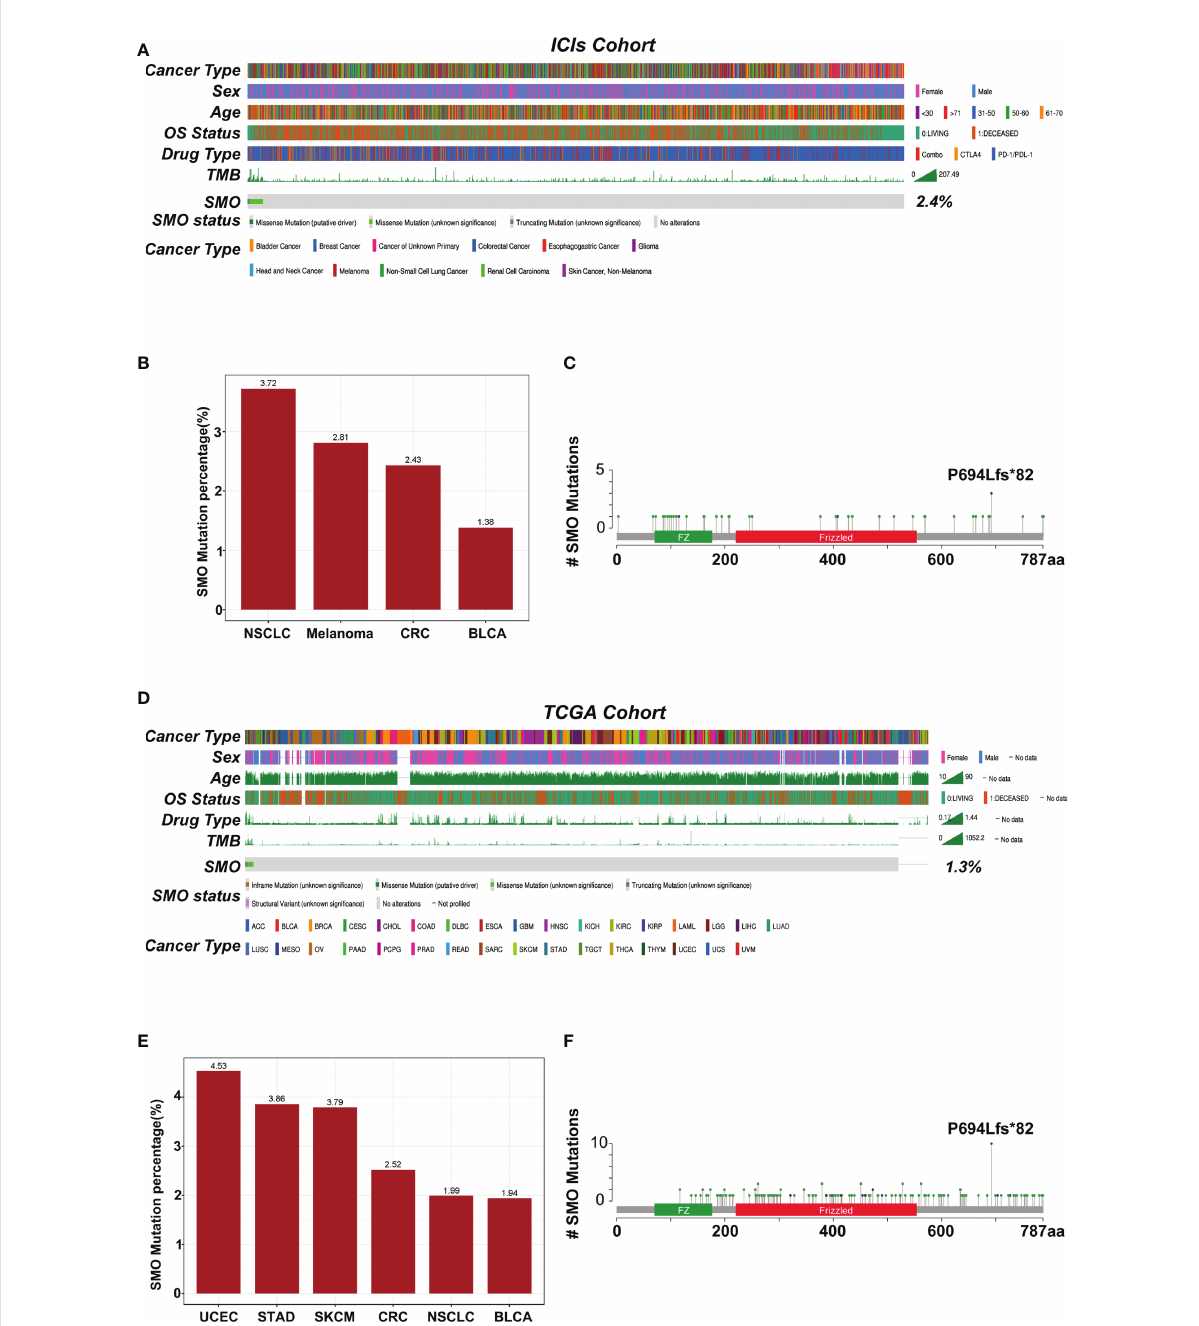
FIGURE 3 Mutational landscape of the distribution of SMO mutations in the pan-cancer cohorts. (A) Association of the SMO status with the clinical characteristics in the immune checkpoint inhibitor (ICI) cohort (Samstein et al.). The cancer type, sex, age, drug type, tumor mutation burden (TMB), and overall survival (OS) were annotated. Samples were sorted based on the SMO mutation status. (B) Proportion of SMO mutant (SMO_MUT) tumors identi fi ed in each cancer type with at least 1% proportion in the ICI cohort. Numbers above the bar plot indicate the alteration frequency. (C) Lollipop plot showing the distribution of SMO mutations in the ICI cohort. (D) Association of the SMO mutation status with the clinical characteristics in The Cancer Genome Atlas (TCGA) cohort. The cancer type, sex, age, microsatellite instability (MSI) score, TMB, and OS were annotated. (E) Proportion of SMO_MUT tumors identi fi ed in each cancer type with at least 1% proportion in the TCGA cohort. Numbers above the bar plot indicate the alteration frequency. (F) Lollipop plot showing the distribution of SMO mutations in the TCGA